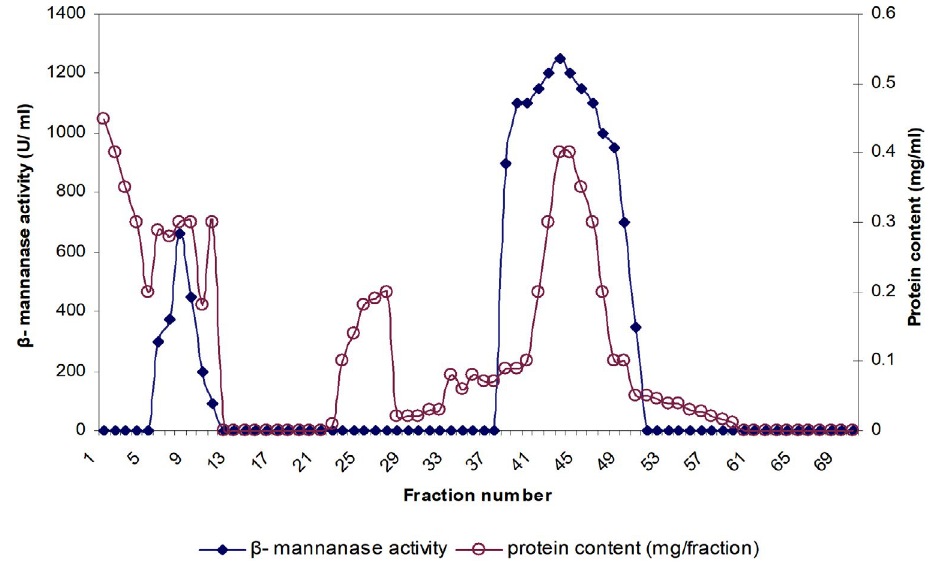
Fig. 1. Hydrophobic interaction chromatography of β-mannanase active fractions, obtained after phenyl sepharose column chromatography. Fractions were tested for protein (—o—) and β- mannanase activity (— ■